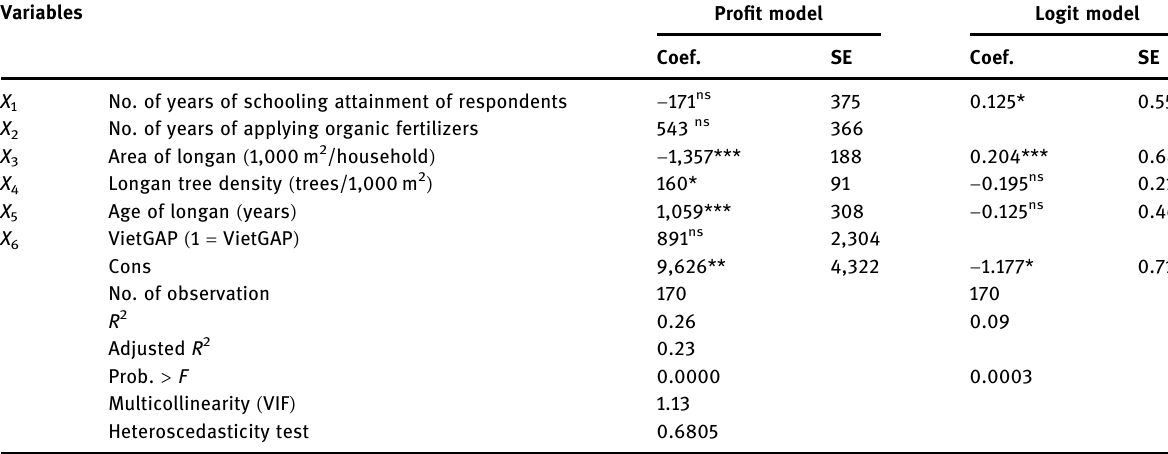
Table 4: Factor a ff ecting pro fi t and decision to adopt VietGAP of Idor longan growers in the Mekong Delta,